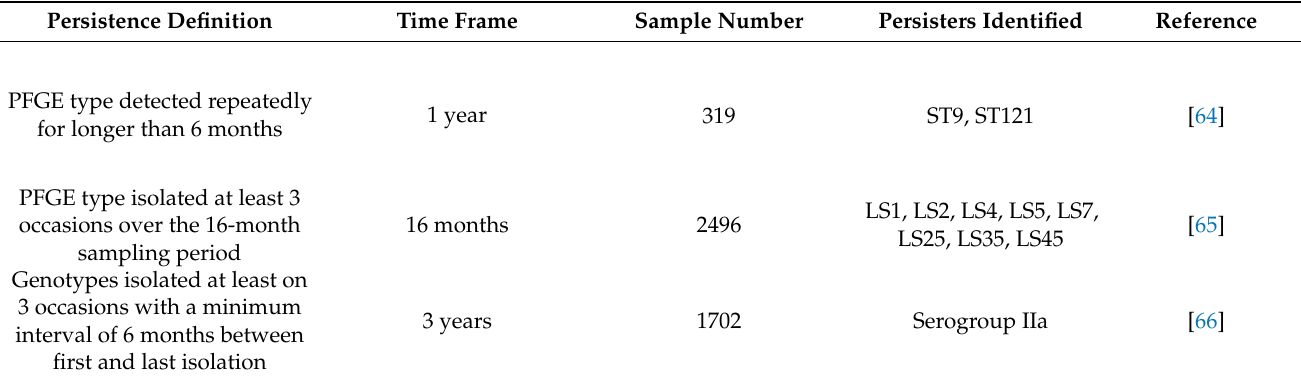
Table 2. Criteria used to define persistence of Listeria monocytogenes in